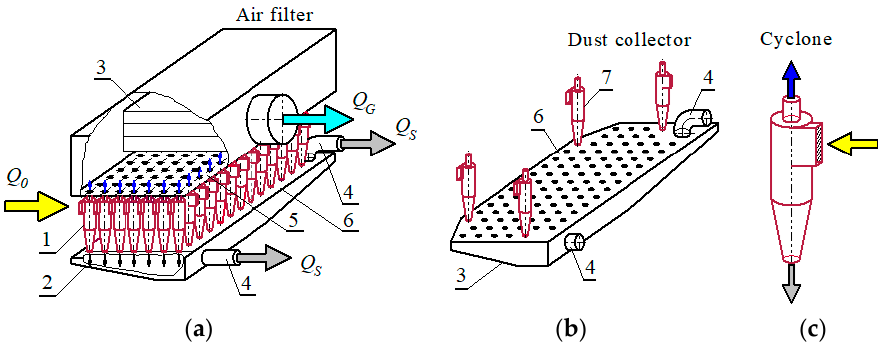
Figure 19. The elements of the air filter of the tracked vehicle T: ( a ) air filter, ( b ) dust collector, ( c ) return-flow cyclone with tangential inlet, 1—multicyclone, 2—dust collector, 3—filter cartridge (cassettes), 4—dust suction ducts, 5—upper fixing plate of cyclones, 6—lower fixing plate (collector upper wall) of collectors, 7—cyclone.